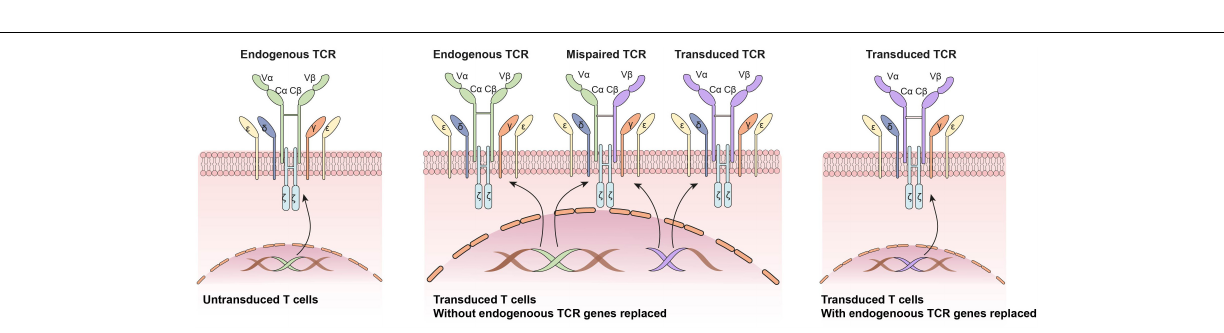
FIGURE 3 | Application of CRISPR/Cas9 system in engineered T cell receptor (TCR)-based adoptive T cell therapy: Knocking out endogenous TCRs to avoid mixed TCR dimer formation and improve transduced TCR